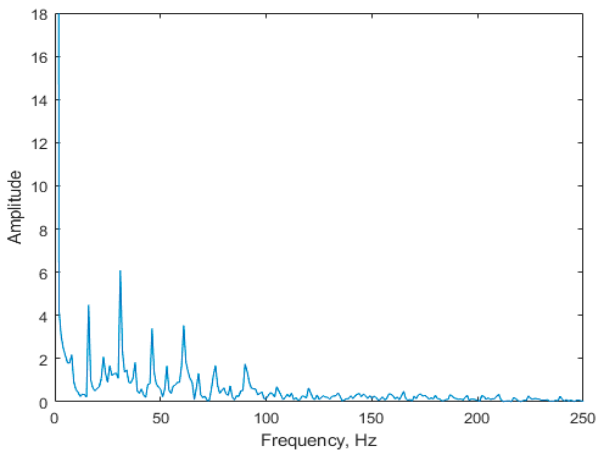
Figure 18. Amplitude spectrum of a faulty asynchronous motor in steady state.